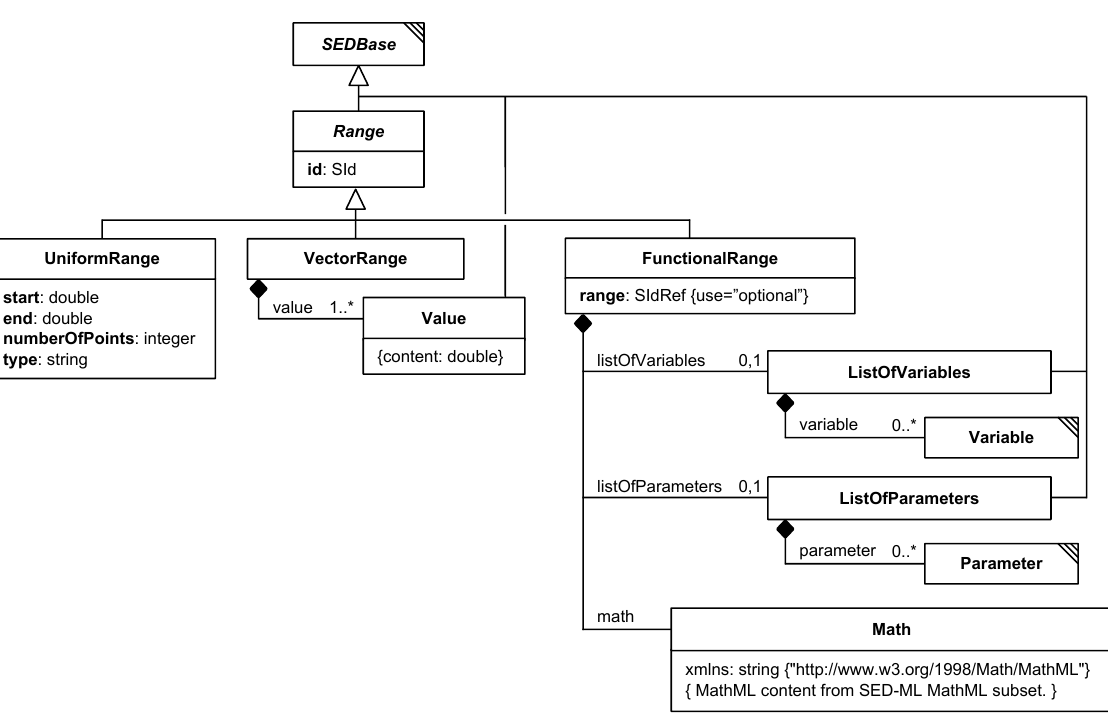
Figure 2.14: The SED-ML Range